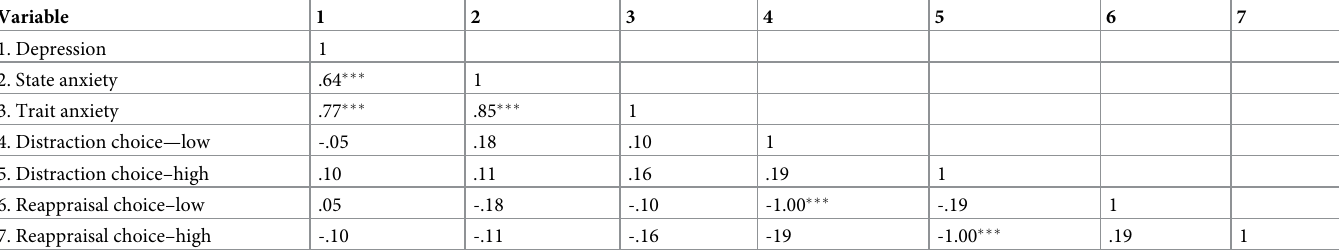
Table 2. Zero-order correlations between depression, anxiety, and the different conditions in Experiment 1A.